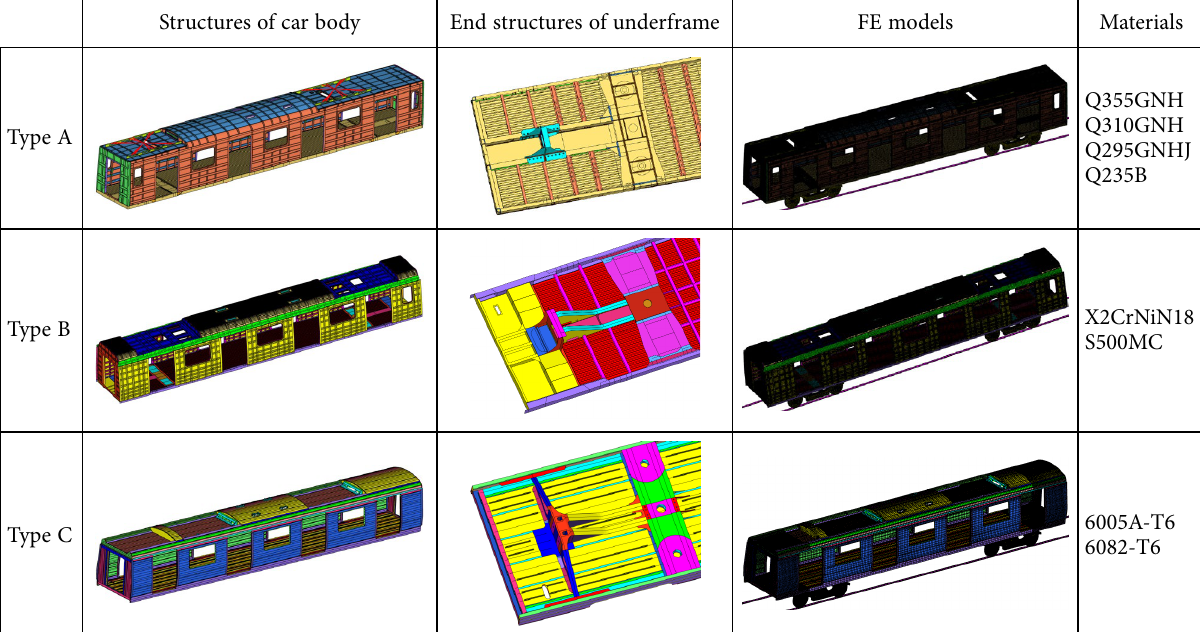
Table 2. Comparison of three typical car body structures and materials Structures of car